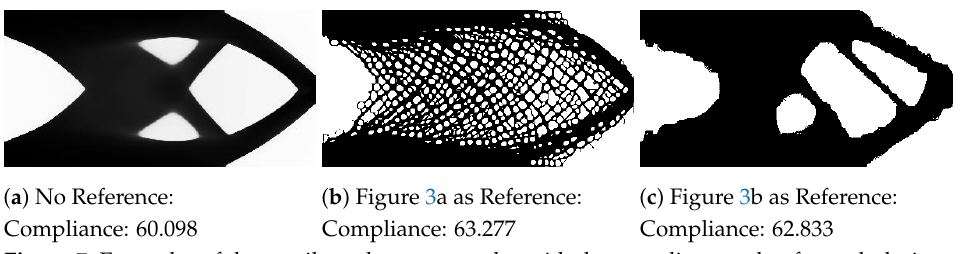
Figure 7. Examples of the cantilever beam examples with the compliance value for each